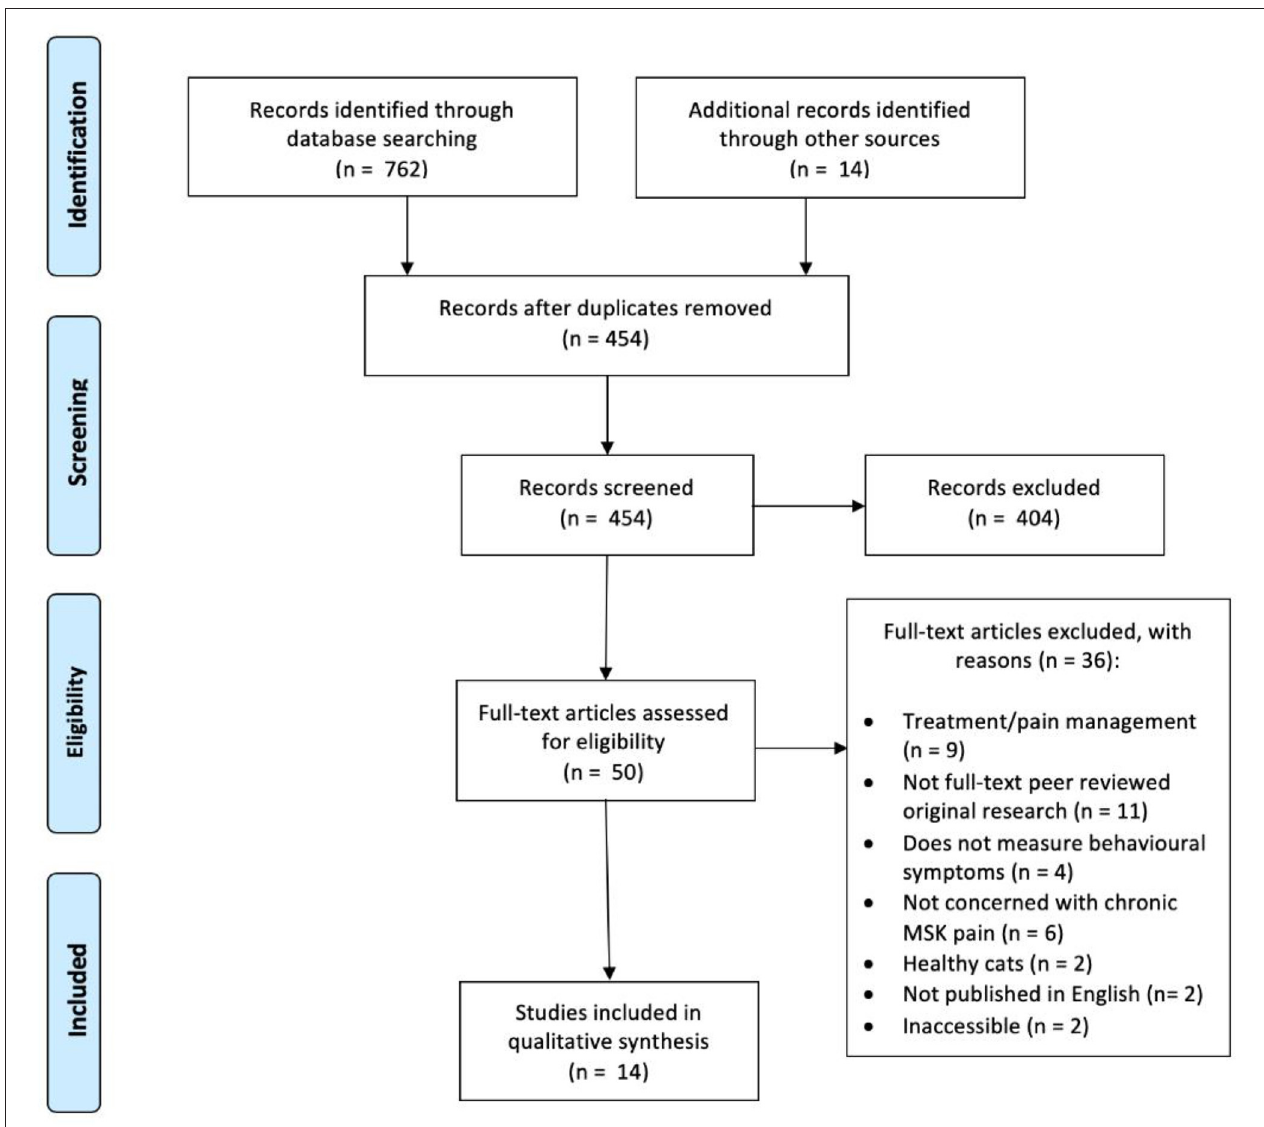
FIGURE 1 | PRISMA flow